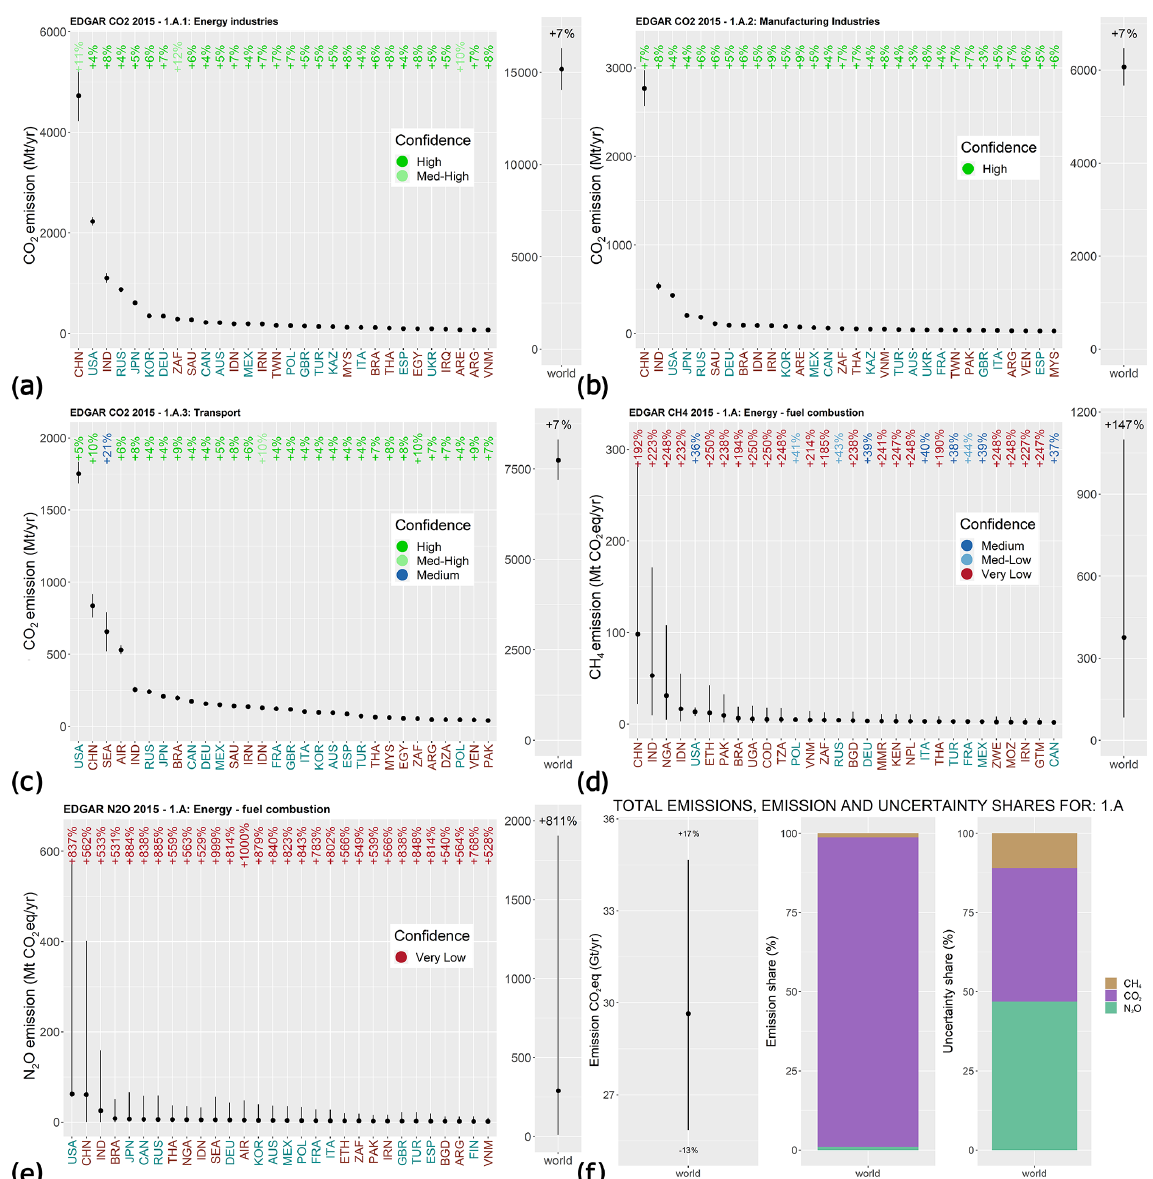
Figure 1. GHG emissions from top emitters and the world for sector 1.A (energy from fuel combustion): (a) CO 2 from energy industries; (b) CO 2 from manufacturing industries; (c) CO 2 from transport; (d) CH 4 from fuel combustion; (e) N 2 O from fuel combustion; (f) the world total emission uncertainty and the world emission and uncertainty shares. The country names are colour-coded according to their classification (cyan denotes industrialized, and red denotes developing). Confidence levels are given in the following ranges: high (0%, 10%]; medium-high (10%, 20%]; medium (20%, 40%]; medium-low (40%, 60%]; low (60%, 100%]; and very low > 100%. (Country codes are given in Table